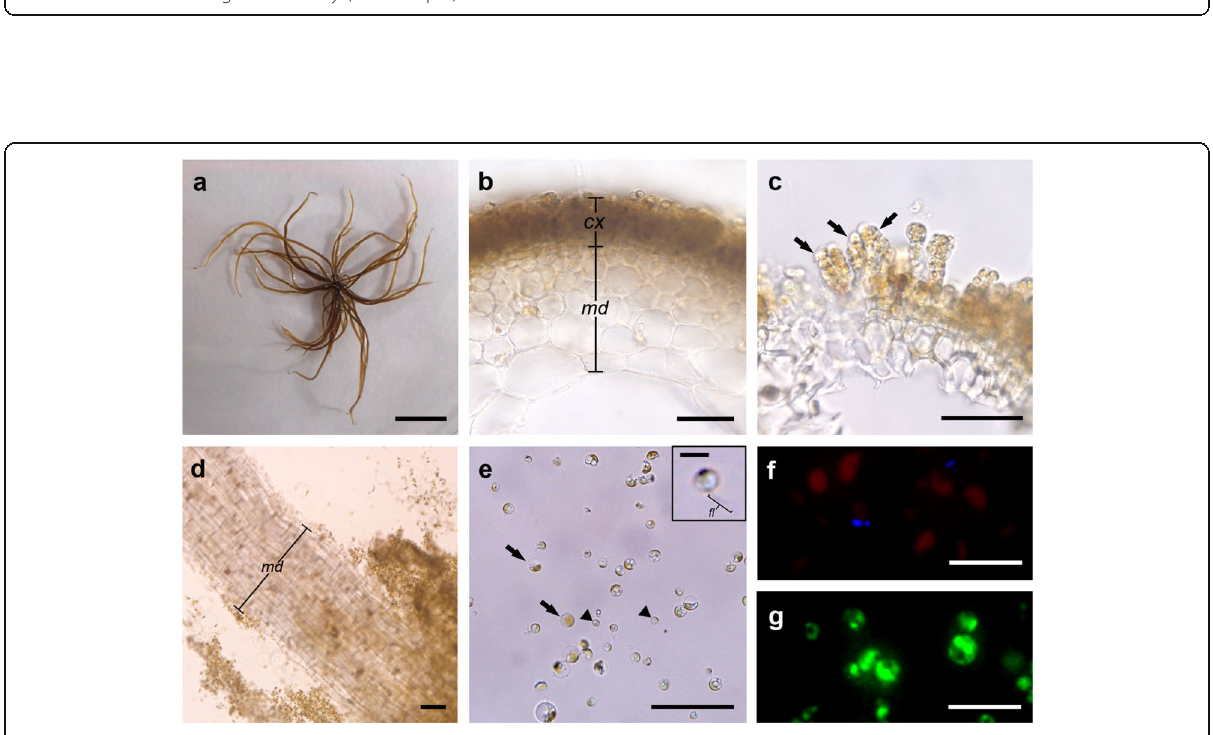
Fig. 2 Protoplast isolation from Scytosiphon lomentaria . a Mature macrothalli after 2 months in suspension culture (bar = 1 cm). b Cross section view of macrothallus showing cortex ( cx ) and medulla ( md ) (bar = 50 μ m). c Plurilocular sporangia (arrows) from a mature macrothallus (bar = 50 μ m). d Thallus under enzymatic process showing undigested medulla ( md ) (bar = 100 μ m). e Freshly isolated protoplasts (arrows) from somatic cells and zooids (arrowheads) with flagellum ( fl ) from digested plurilocular sporangia (bar = 50 μ m; bar in inset = 5 μ m). f True protoplasts with red chlorophyll autofluorescence under inverted fluorescence microscope showing no cell walls (bar = 10 μ m). g Protoplasts with green fluorescence stained with FDA showing their viability (bar = 10 μ